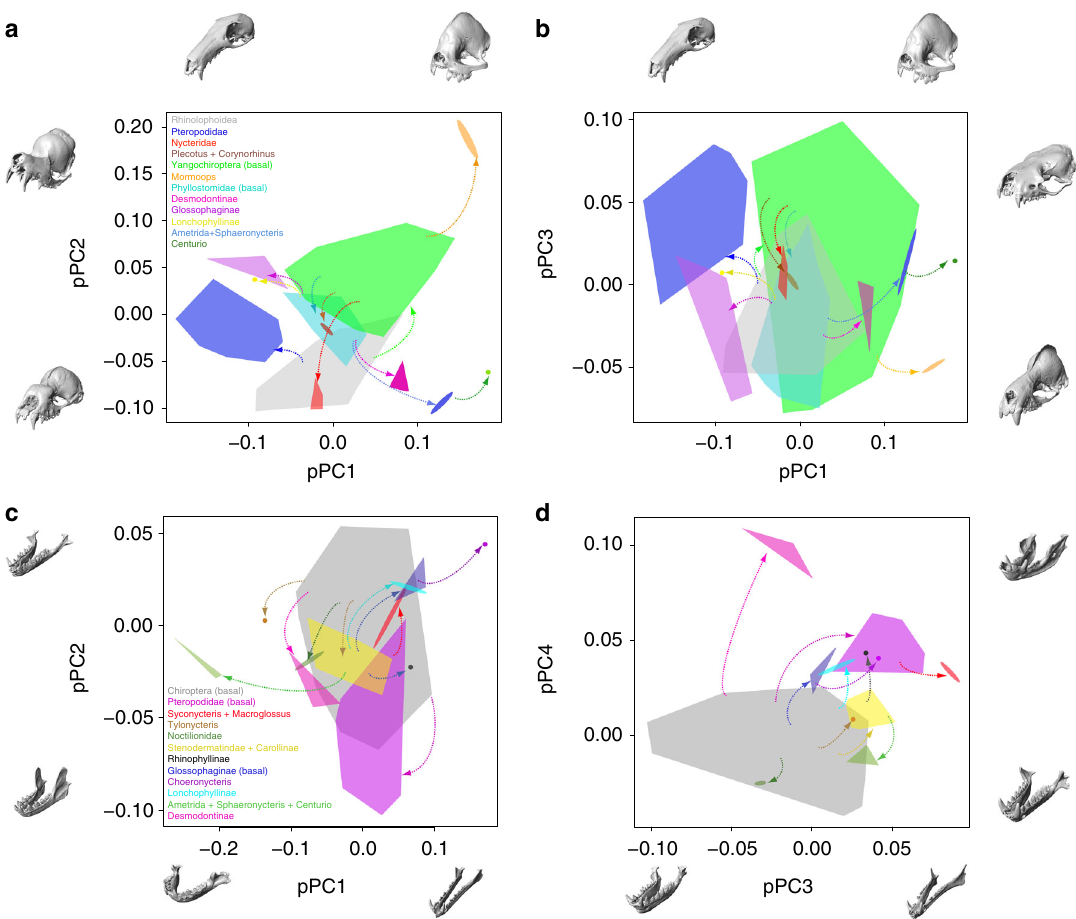
Fig. 6 Adaptive shifts in cranial and mandibular morphospaces (pPC scores). Digital models of crania and mandibles from μ CT data illustrate the trends across each axis, 3D models were visualized using Checkpoint. Illustrated taxa as in Fig. 1. Polygons indicate pPC score distributions of all species representing an adaptive evolutionary regime shift for the cranium ( a , b ) or mandible ( c , d ) with at least 0.7 bootstrap support. Arrows indicate the transition between ancestral adaptive regime (gray polygon) and the new adaptive regime for each evolutionary shift. Colors of adaptive regimes match